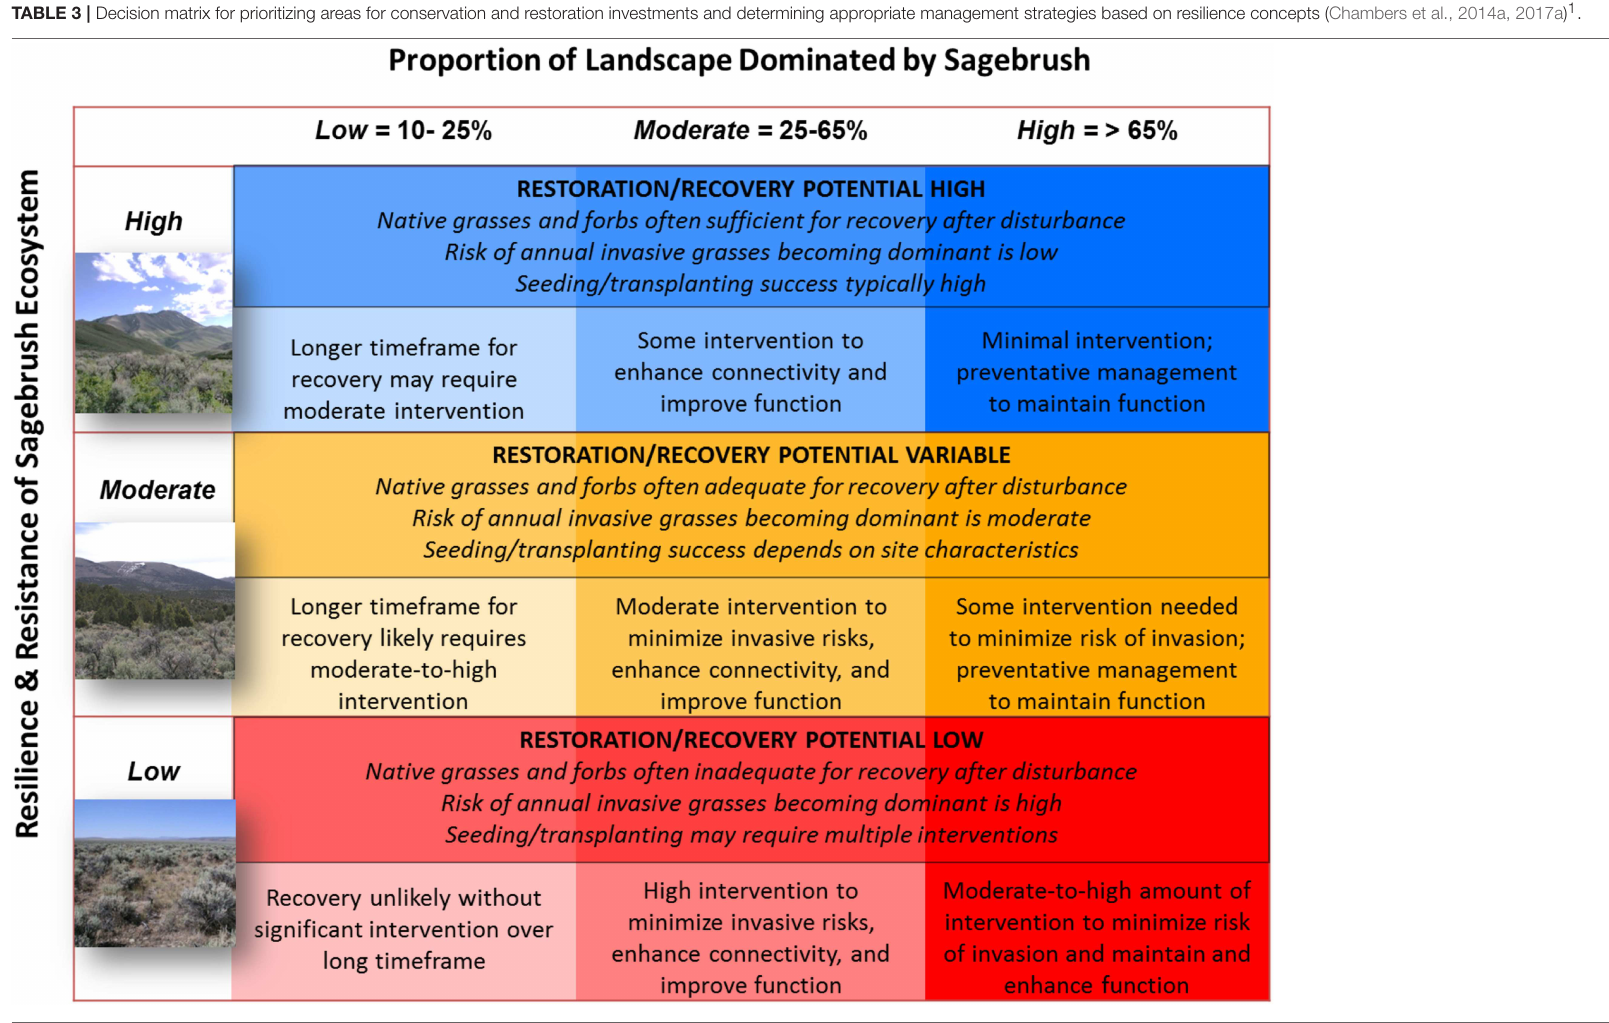
Rows show relative resilience to disturbance and resistance to invasive annual grasses (high, moderate, low). Resilience and resistance categories were derived from soil temperature and moisture regimes (Maestas et al., 2016; Chambers et al., 2017a) and relate to broad-scale sagebrush ecological types. Columns show the landscape cover of sagebrush (low = < 0.25%, moderate = 25–65%, high = > 65%). Categories of sagebrush landscape cover are based on ecological minimum requirements underlying sage-grouse distributions (Knick et al., 2013; Chambers et al., 2014c) and are used here as a metric for evaluating spatial resilience. Considerations for using the matrix and determining management strategies are in